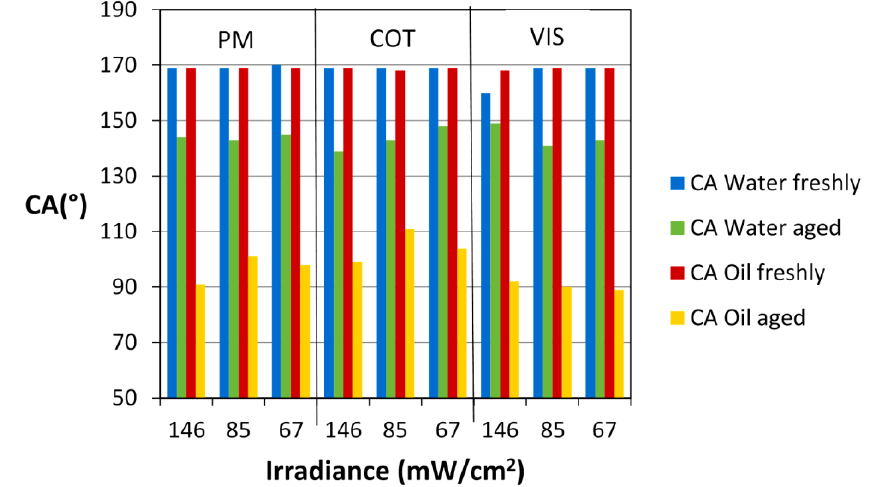
Figure 8. Water and oil CA on each fabric vs. irradiance. Comparison between fresly prepared and aged samples (two years) UV treated with 20 g/L Oleophobol concentration.